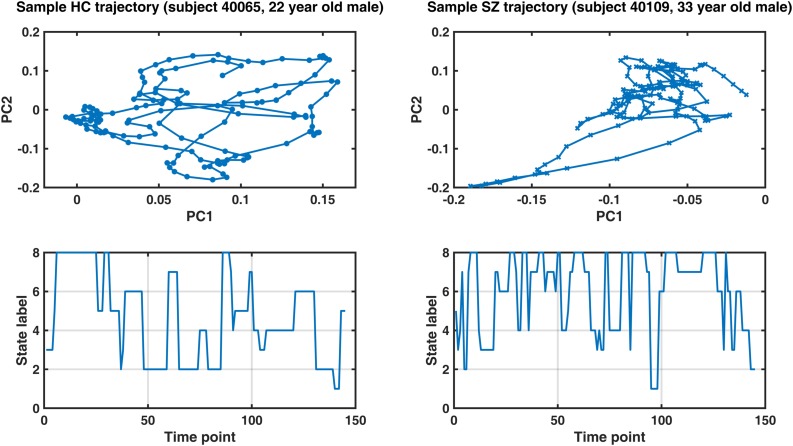
Sample IPS trajectories from a healthy control subject (HC, left panel) and a schizophrenia patient (SZ, right panel). Top panels: IPS trajectories in low-dimensional manifolds (spanned by the first two principal components, PC). Notably, the HC subject covers a larger space and realizes a smoother trajectory (compared to the patient). Lower panels illustrate the corresponding state sequences. The healthy subject spends longer periods in states 2 and 4 (which belong to metastate 1), while the patient’s sequence mostly avoids states 1 and 2, but visits states 5–8 more often (which are associated with metastate 2). Please refer to Table 3 for group differences in IPS trajectory measures.